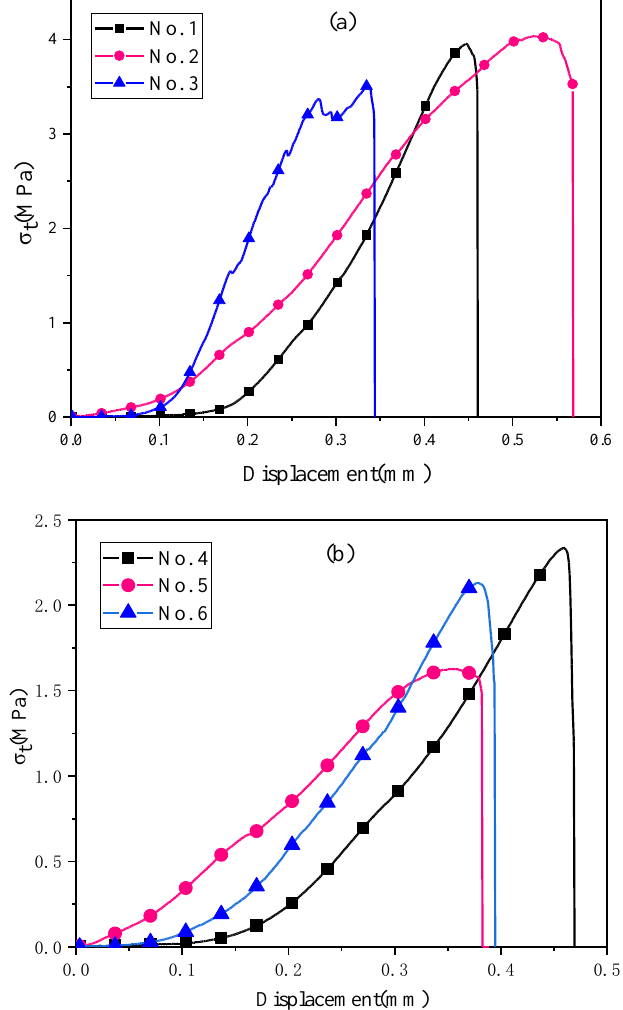
Figure 8. Tensile stress–displacement curve of ( a ) black sample and ( b ) white sample. Figure 9 shows the splitting failure modes of black and white SMS specimens. In general, the final failure mode of these specimens is consistent. Each specimen produces radial penetrating cracks along the sample immediately after reaching the peak radial pressure, which also shows that the Brazilian splitting test can effectively obtain the ten- sile strength parameters of polymetallic sulfide samples. However, the crack of the No. 3 specimen shifted radially, which may have been caused by the influence of pores in the specimen. In addition, as shown in Table 2, the tensile strength of the No. 5 specimen was significantly lower than that of other specimens in the white group, and no obvious crack was found after failure; the data of the No. 5 specimen were judged as failure and elimi- nated.